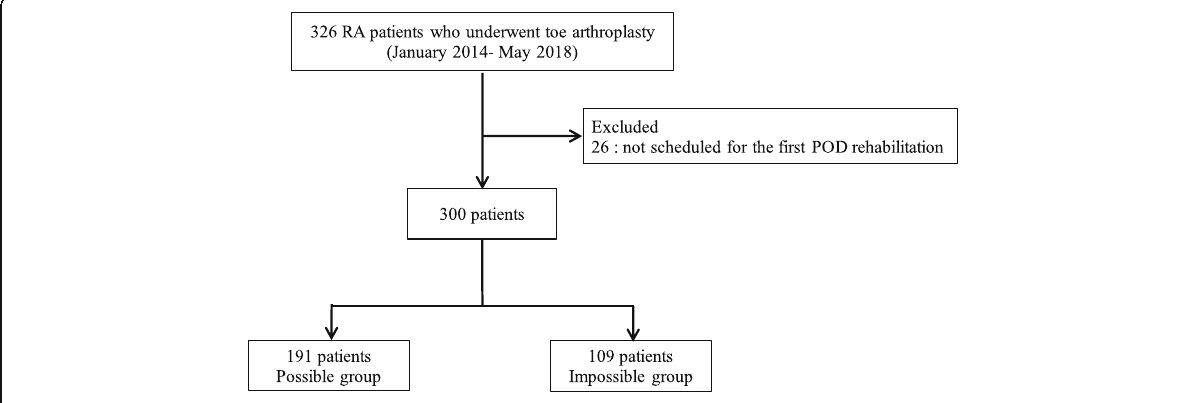
Fig. 1 Flow chart of patients selection. RA, rheumatoid arthritis; POD, postoperative